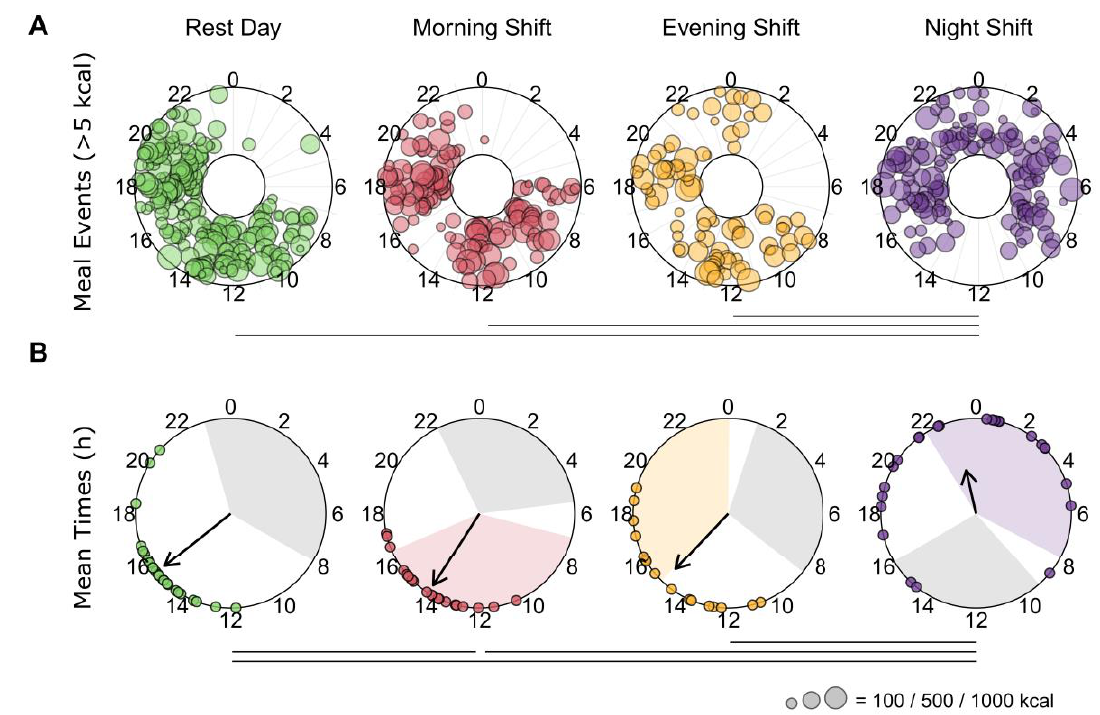
Figure 3. Meal events and average caloric intake by time-of-day. ( A ) Individual meal intakes (>5 kcal) are depicted as colored circles in concentric rings for each participant. The sizes of the colored circles reflect the total caloric content of the meal. Horizontal lines represent significant differences in the spread or dispersion of caloric intake around the clock between day types. The spread per participant is derived from rho, the mean resultant vector length of circular data. On average, calories were more dispersed for night-shift days than other day types (Supplementary Table S3). ( B ) Weighted circular mean times of caloric intake for each participant on each day type are depicted as colored circles. The direction of the arrows identifies the group circular mean time for each day type. The length of the arrows represents the consistency of individual mean intake times, with smaller arrows indicating a larger spread. Colored regions depict the average work hours for each shift type. The grey regions depict the average times of the main sleep period for each shift type (based on the wake and sleep onset times before and after each day, respectively). Horizontal lines represent significant differences (adjusted, p < 0.05) in the timing of caloric intake between day types. Mean times of caloric intake occur later on night-shift days than all other days, and earlier on morning-shift days than rest days (Supplementary Table S3).